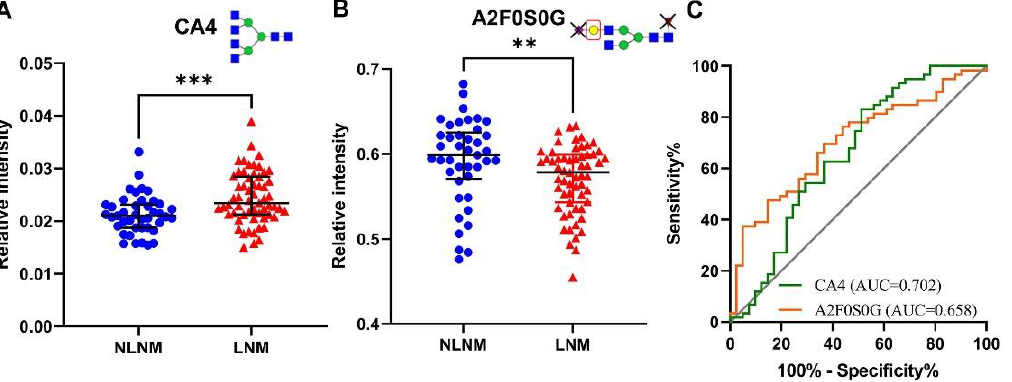
Figure 3. The scatter plots and ROC curve analysis of two prominently different derived N -glycan traits between PTMC with LNM and with non-LNM groups. ( A ) scatter plot for CA4, ( B ) scatter plot for A2F0S0G, and ( C ) ROC curve analysis for two differential expressed derived glycan traits. *** represents p -value < 0.001, ** represents p -value < 0.01 (after multiple testing correction). Notes: mannose, green circle; GlcNAc, blue square; fucose, red triangle; galactose, yellow circle; sialic acid, purple diamond. Abbreviations: ROC, receiver operating characteristic; PTMC, papillary thyroid microcarcinoma; LNM, lymph node metastasis; AUC, area under the curve.